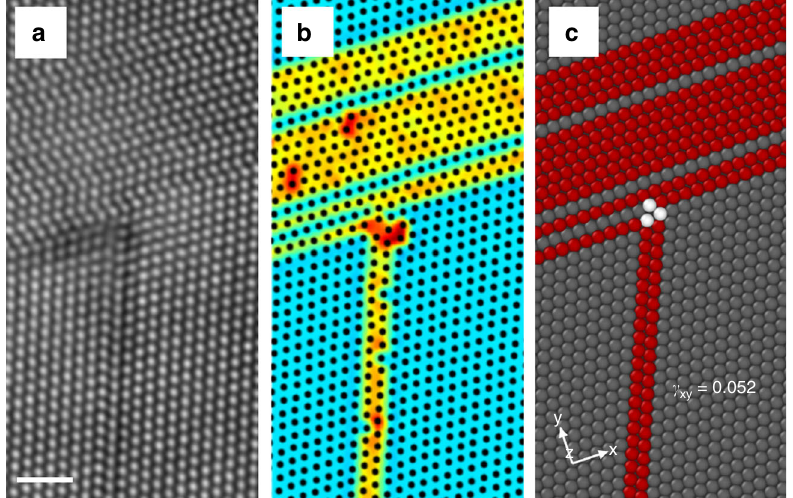
Fig. 7 Comparison between experimental observation of deformation mechanisms in CrCoNi and atomistic simulation of fcc Co as a surrogate system. a A HAADF-STEM image of what appears to be the interaction between incoming dislocations and the existing hcp lamella with the corresponding center of symmetry map, shown in b . c A similar structure created by the simulation of two screw dislocations interacting with an hcp region of the same size in fcc Co. The second screw dislocation is out of the frame of the image. The clear similarity between the experimental and simulation images suggests that the structure in a , b are likely to have been created from a similar dislocation interaction with already formed hcp regions. The scale bar in a represents 1